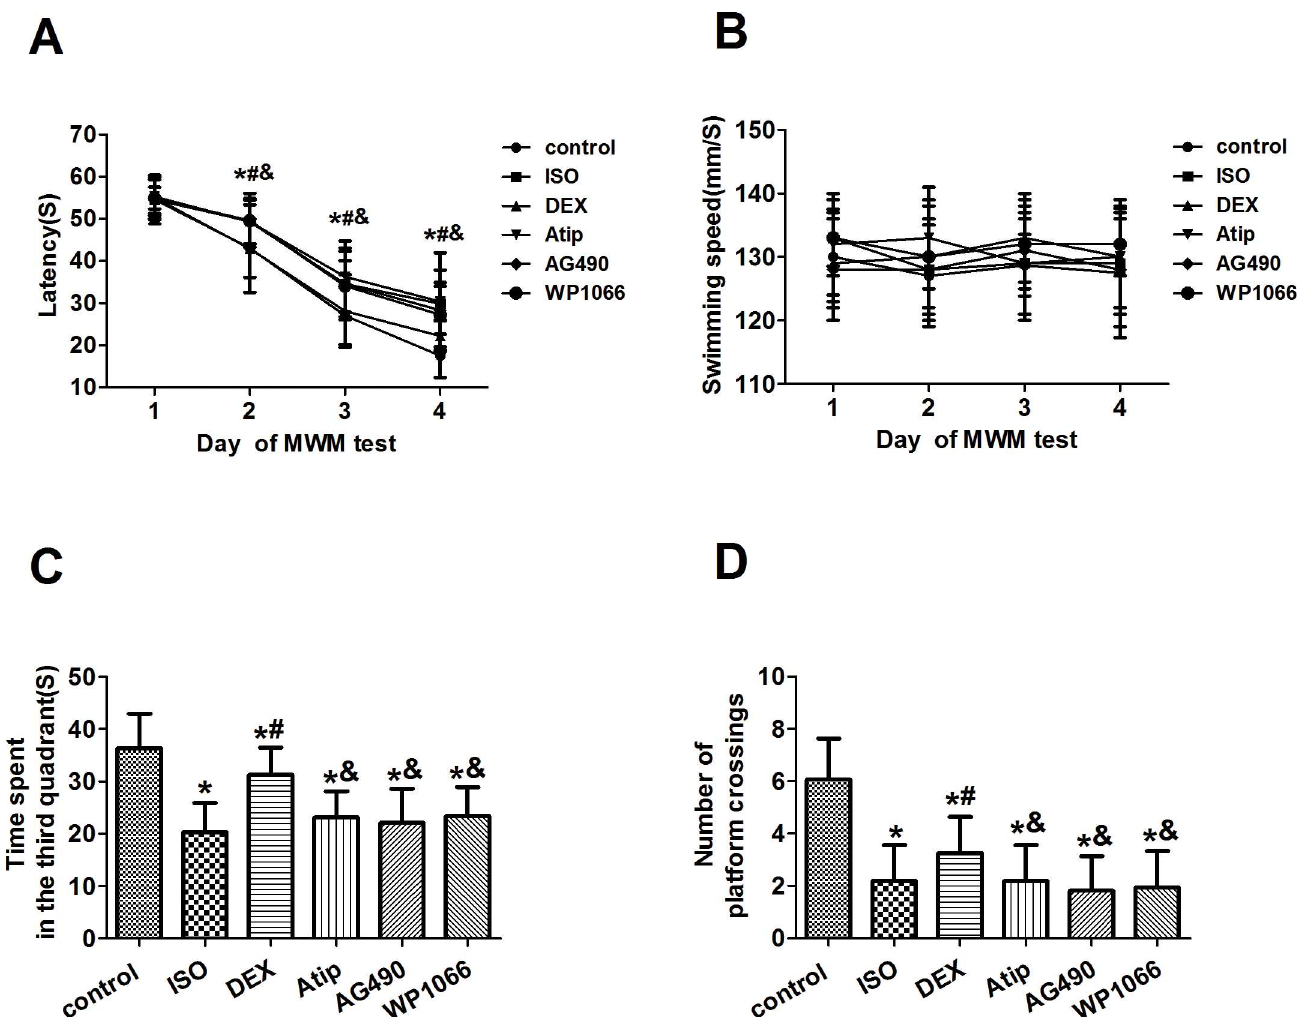
Fig 1. Effects of dexmedetomidine pretreatment on isoflurane-induced behavioral deficits. Latency for mice to reach the target platform (A) and swimming speed (B) were measuredduring spatial acquisition training and testing on days 1–4. On day 5, the number of crossings over the originaltarget platform (C) and the time spent in that quadrant(D) were measured. Data are representedas mean ± SD (n = 16). * P < 0.05 vs. control group; # P < 0.05 vs. isoflurane(ISO) group; & P < 0.05 vs. dexmedetomidine (DEX) group.